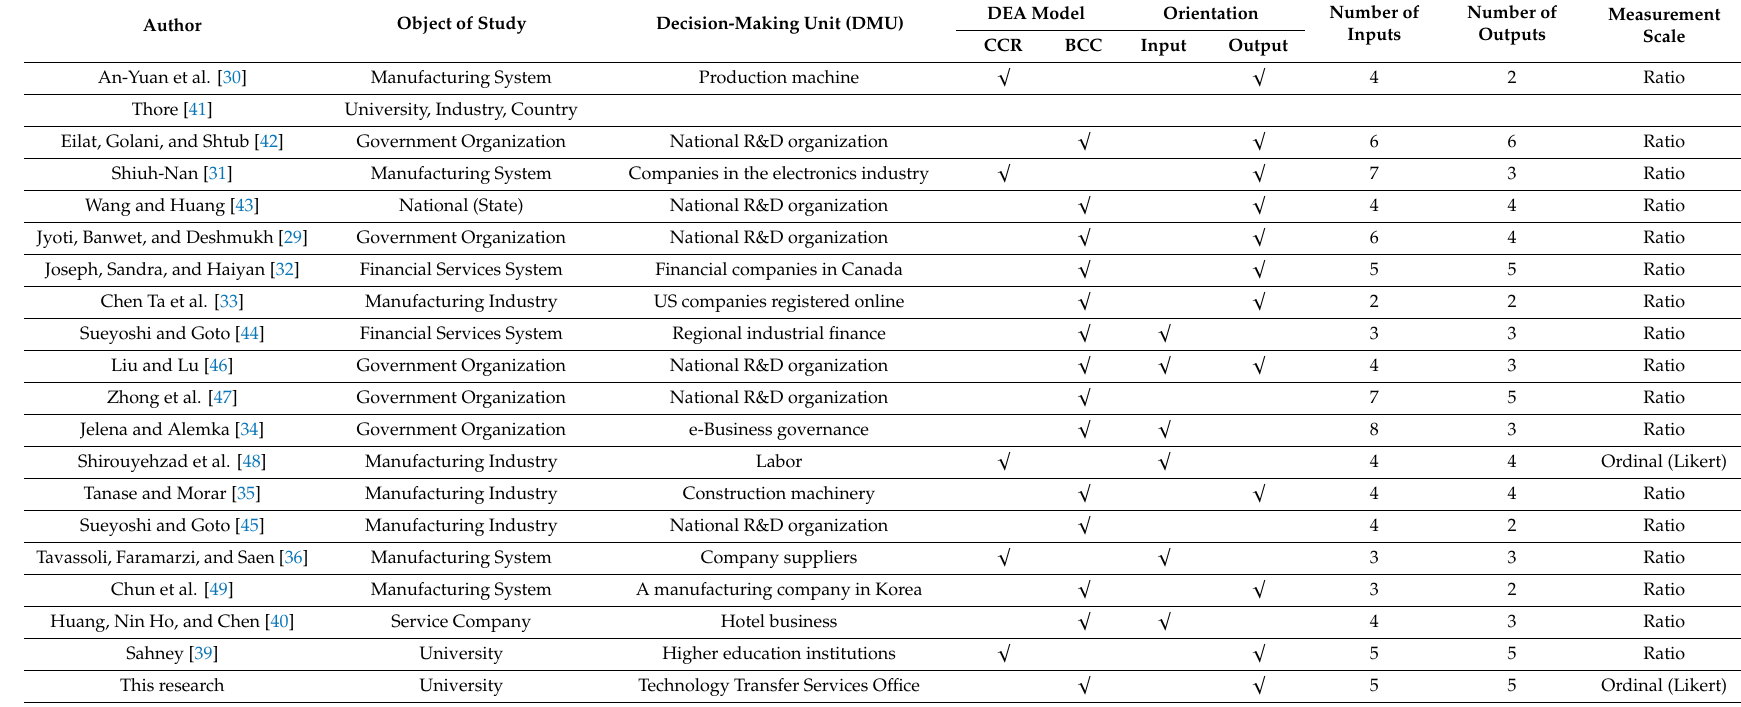
Table 1. State of the art of this